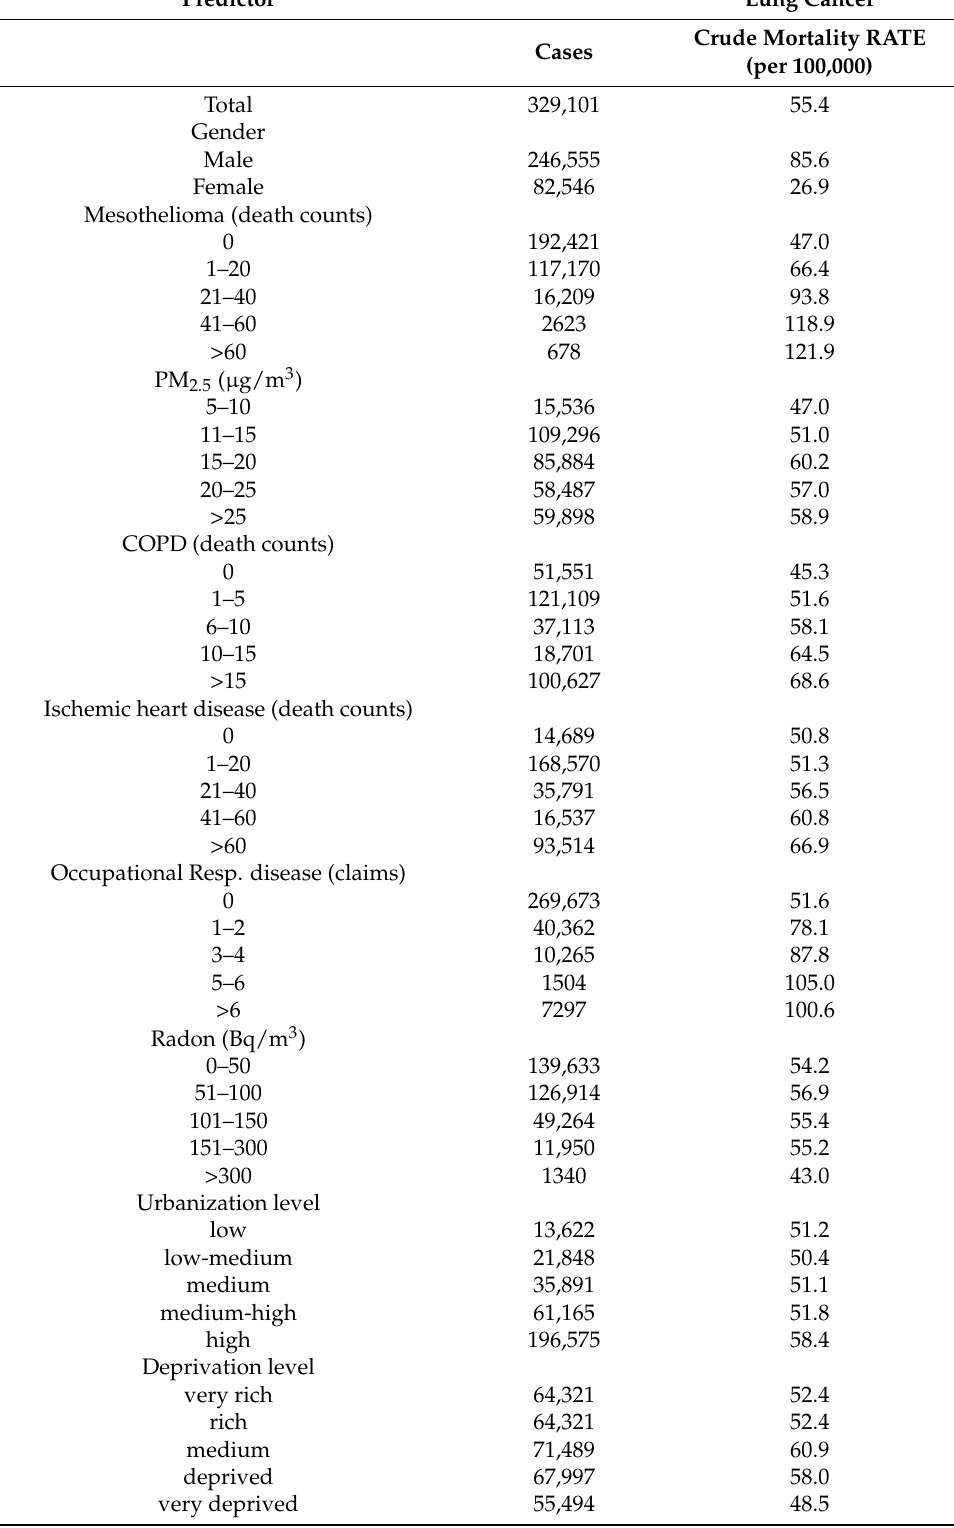
Table 3. Crude lung cancer mortality counts/rates by predictor